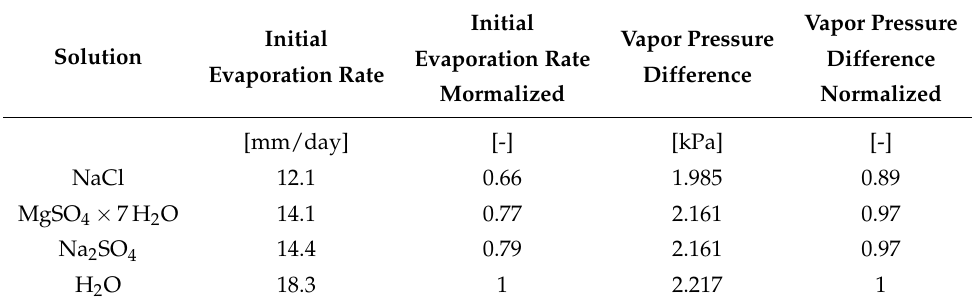
= 0.950kPa was amb